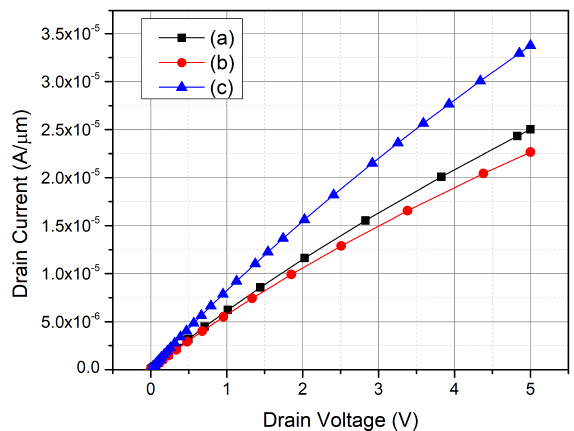
Figure 9. Forward I d -V d diagram of the three structures ( a ) traditional vertical MOSFET, ( b ) FSJ MOSFET, ( c ) DC-FSJ MOSFET.